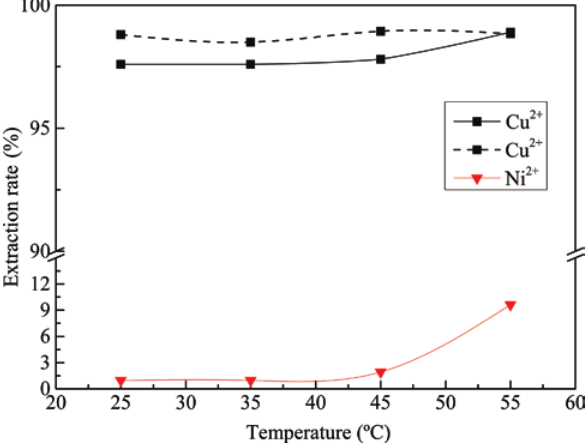
best copper extraction rate and copper-nickel separation effect, the optimum initial pH should be set at 2.5.